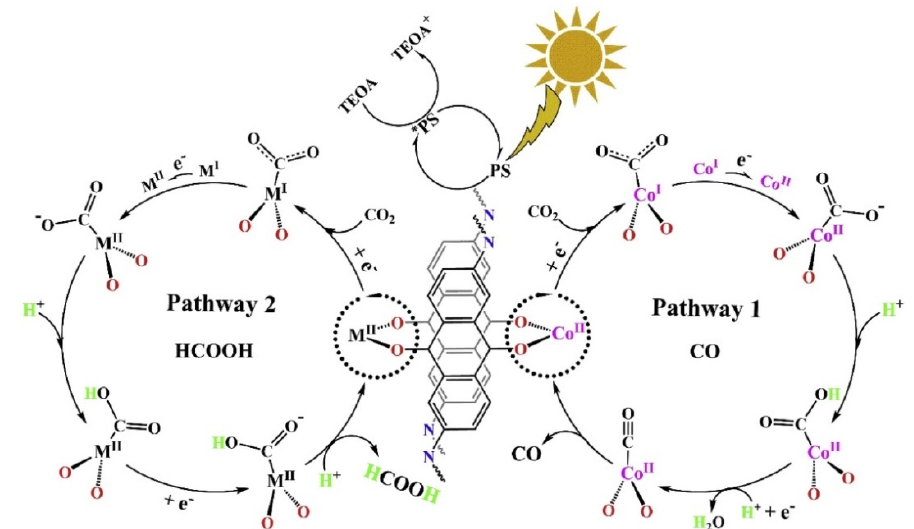
Figure 1. Proposed mechanism for the photocatalytic reduction of CO 2 with DQTP-COF-M ((M = Zn, Ni and Co). Copied with permission from Elsevier 2019 [30].